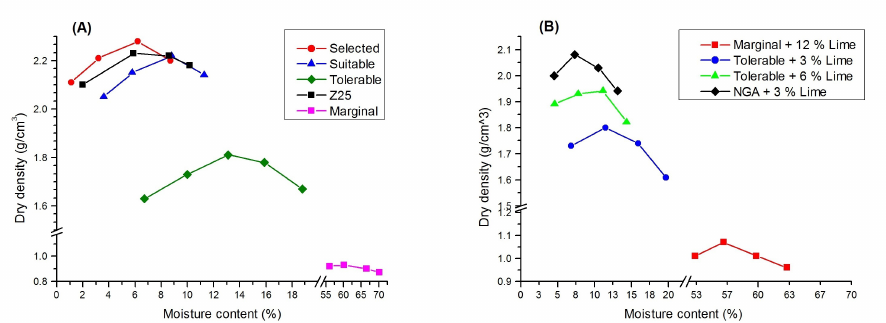
Figure 3. Moisture versus density relationships for four subbase materials prepared as: ( A ) classified soils, and ( B ) stabilized